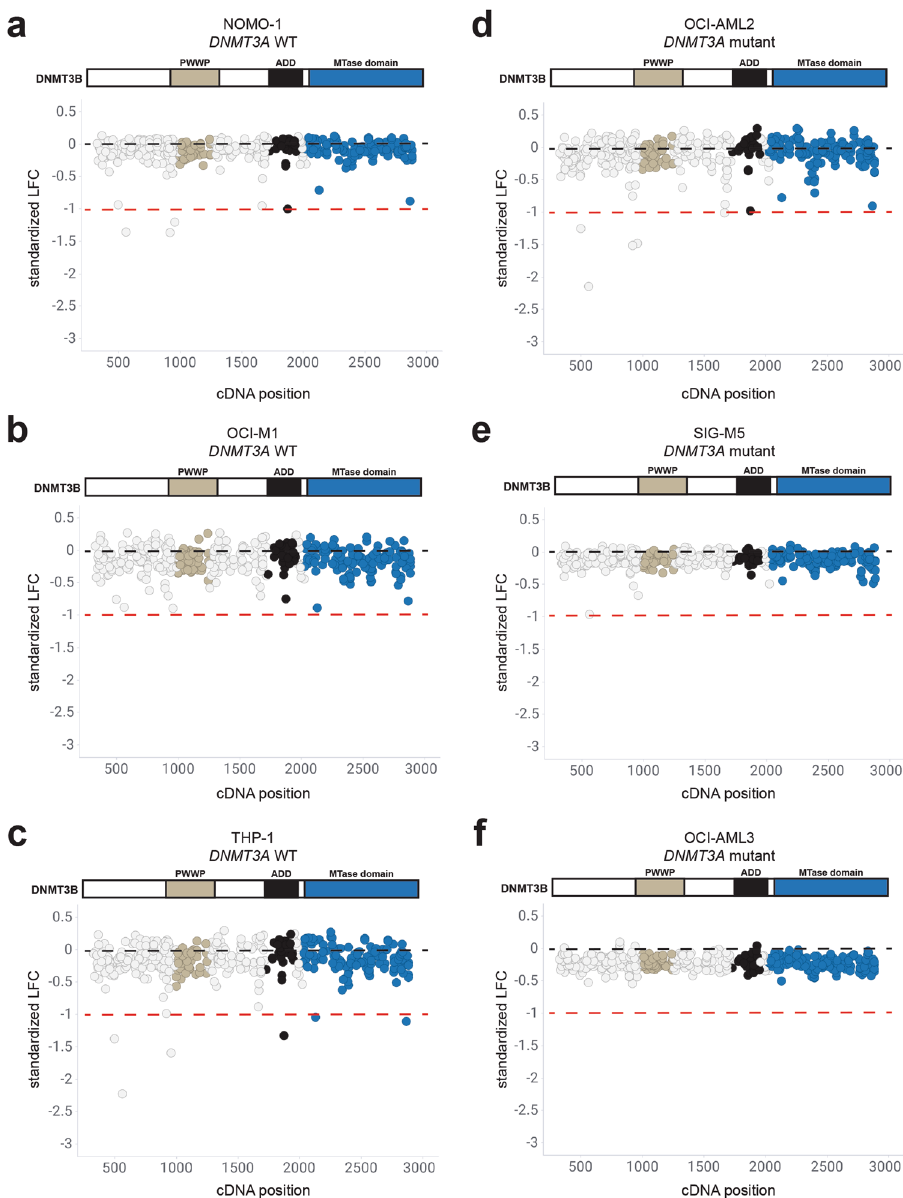
Fig. 3 Knockout mutations spanning the DNMT3B protein have minimal effects on proliferation across AML cell lines wild-type and mutant for DNMT3A . a – c sgRNAs tiling DNMT3B in AML cell lines wild-type for DNMT3A , NOMO-1 ( a ), OCI-M1 ( b ), and THP-1 ( c ) are shown with respect to their cDNA position along the coding region of DNMT3B. d – f sgRNAs tiling DNMT3B in AML cell lines mutant for DNMT3A , OCI-AML2 ( d ), SIG-M5 ( e ), and OCI-AML3 ( f ) are shown with respect to their cDNA position along the coding region of DNMT3B. Each circle represents an individual sgRNA targeting DNMT3B . The standardized LFC value for each sgRNA is plotted on each graph. The dashed black bar denotes the mean standardized LFC of the non- targeting controls for each cell line. The mean standardized LFC of the common essential sgRNAs is denoted by the red dashed line. The color of each circle represents the functional domain it targets: PWWP (light gray); ADD (black); MTase domain (blue). n = 3 replicates for each cell line